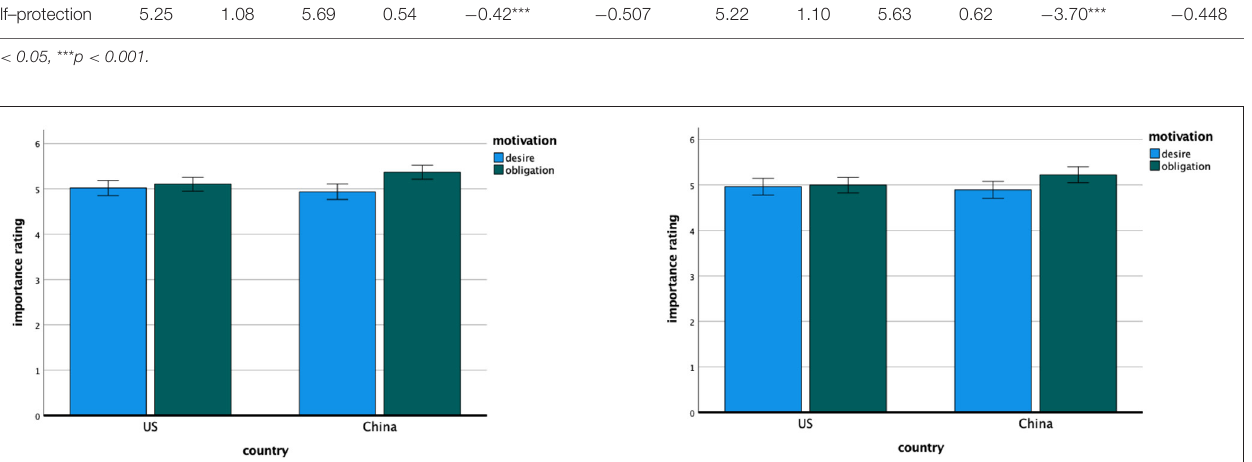
motivations and those of others for compliance with COVID-19 public health guidance. Across all the measures, the standard emphasis on the desire to protect others